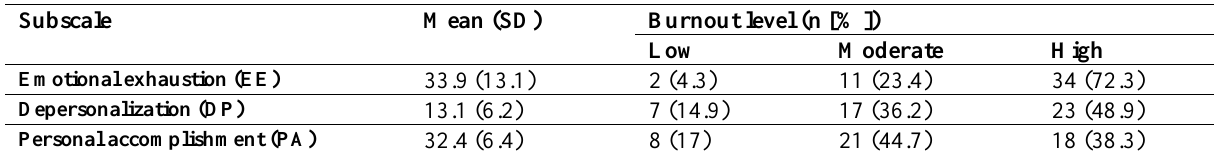
Table3. MBI subscales score and interpretation